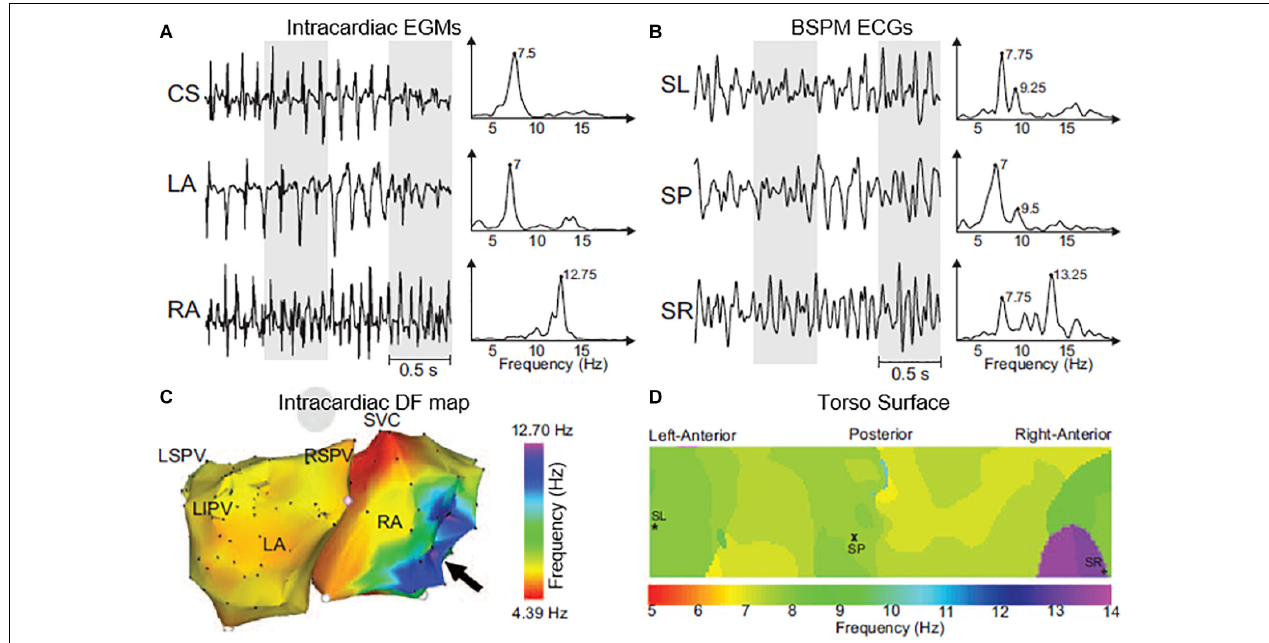
FIGURE 3 | Intracardiac electrograms (EGMs) and body surface ECGs and their dominant frequency (DF) distribution in a sample patient with a right-to-left DF gradient. (A) EGMs recorded at different atrial sites and their corresponding power spectra. (B) Selected BSPM leads and their corresponding power spectra. (C) Intracardiac DF map. Black arrow points to the right atrial (RA) region with highest DF. (D) 2D DF map on the torso surface with superimposed locations of electrodes from (B) . CS indicates coronary sinus; LA, left atrium; LIPV, left inferior pulmonary vein; LSPV, left superior pulmonary vein; RSPV, right superior pulmonary vein; SL, surface left; SP, surface posterior; SR, surface right; and SVC, superior vena cava. Figure modified from Guillem et al.